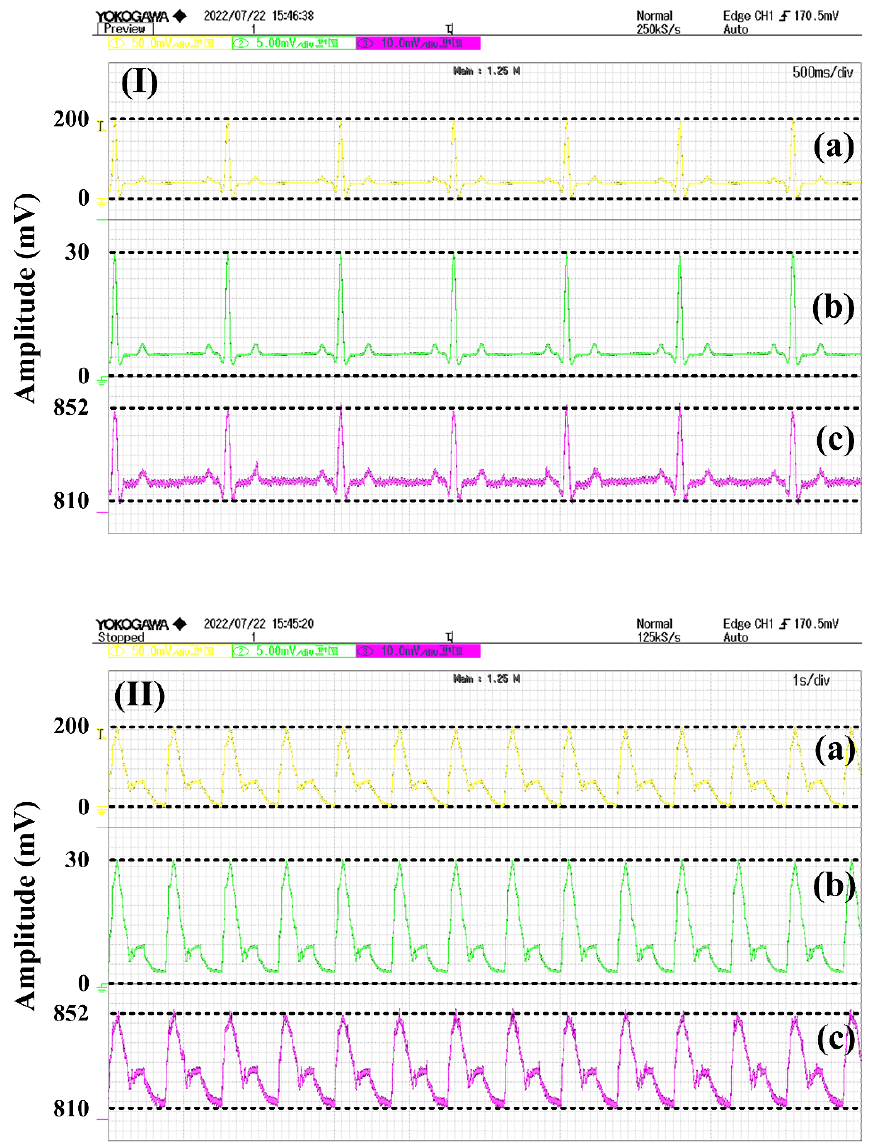
Figure 10. Time-domain characterization of the optoelectronic sensing SoC for two different emulated biomedical signals: panel ( I ) an ECG pattern; panel ( II ) a PPG pattern. In all the panels the digital oscilloscope trace ( a ) is the AWG generated biomedical electrical signal modulating the laser beam power; trace ( b ) is the optical replica of the trace ( a ) detected by PD2 (see Figure 7); and trace ( c ) is the resulting SoC output voltage V OUT .